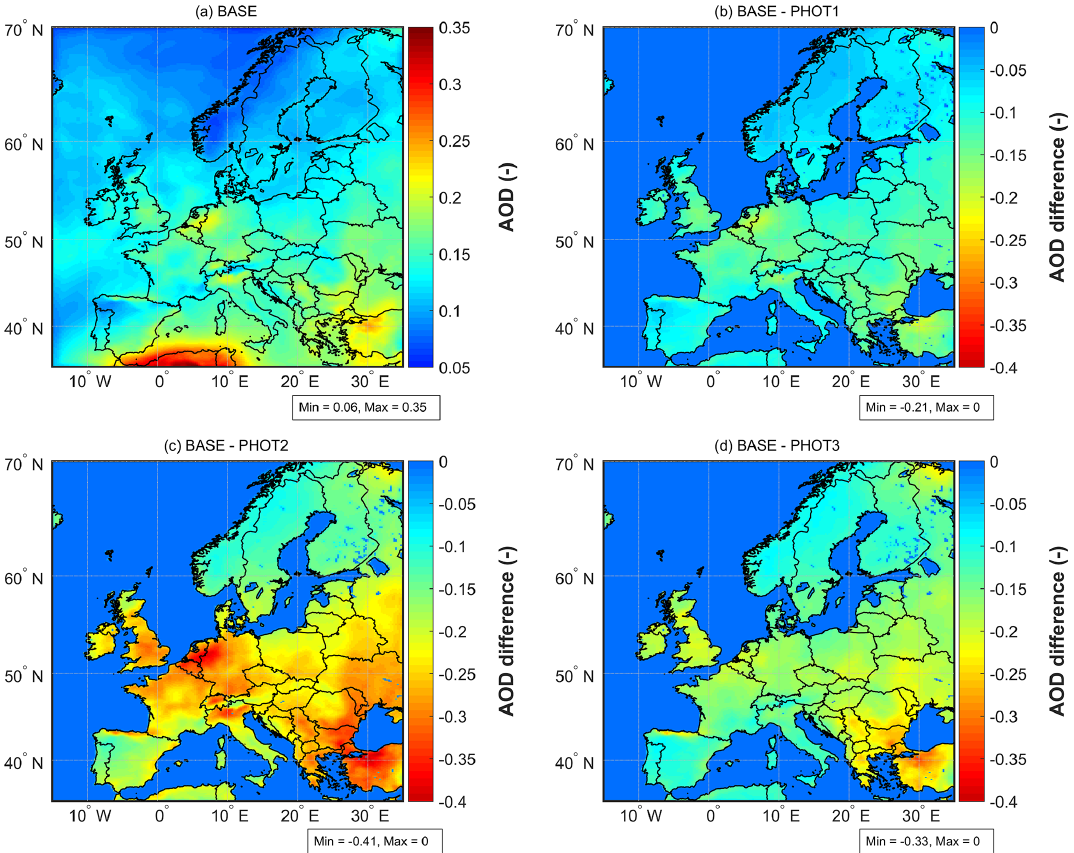
Figure 4. Seasonal daytime (10:00 − 18:00LMT) mean AOD at 350nm for the BASE scenario (a) and AOD differences between the BASE scenario and the PHOT1, PHOT2 and PHOT3 scenarios (b–d) , respectively, in summer 2010. Note the reversed color order in the color scales of panels (b–d)